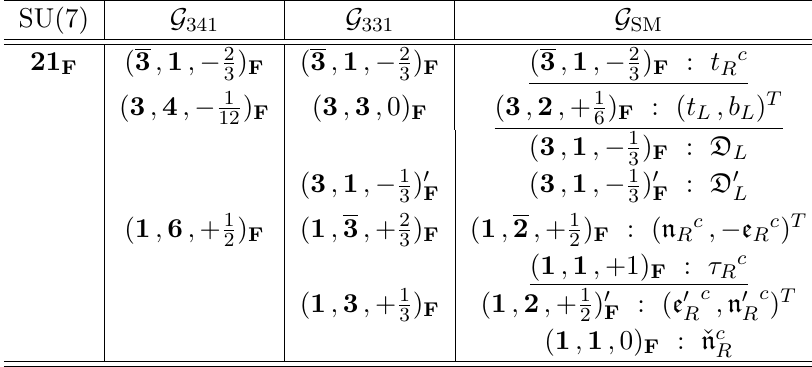
Table 3 . The SU(7) fermion representation of 21 F under the G 341 , G 331 , G SM subgroups for the SU(7) model. All SM fermion names and irreps are identified with underlines.